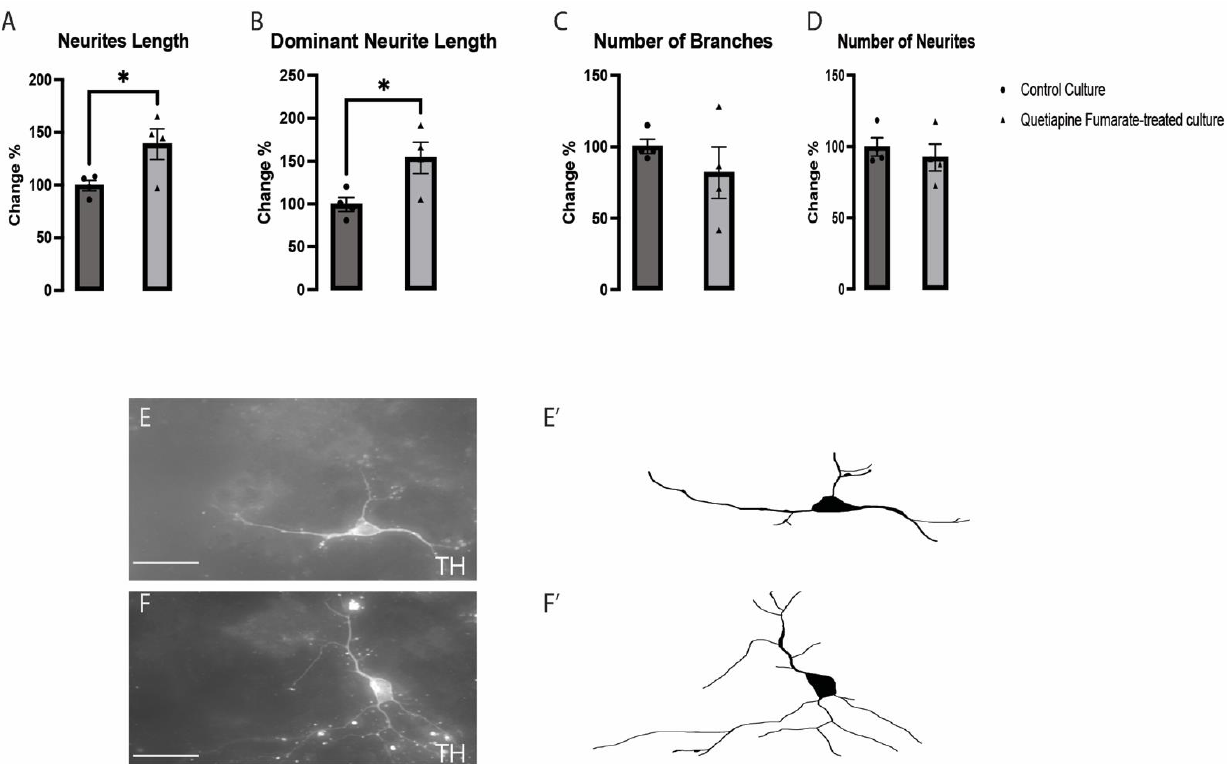
Figure 2. Quetiapine fumarate (QEPF) effects on length of neurites ( A ), dominant neurite length ( B ), number of branches ( C ), and number of neurites ( D ). Representative images and illustrations for dopaminergic VM neurons immunolabeled with TH in both groups: control ( E , E’ ) and QEPF-treated ( F , F’ ) show the increase in neurites elongation in response to QEPF exposure. Data are represented as the mean ± SEM ( n = 3 technical replicates, 4 biological replicates). * p <